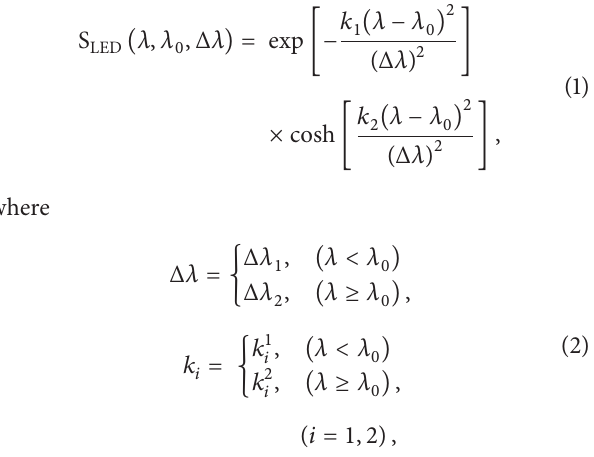
Figure 2: Relative SPDs of WW, red, green, and blue LEDs at drive current of 350